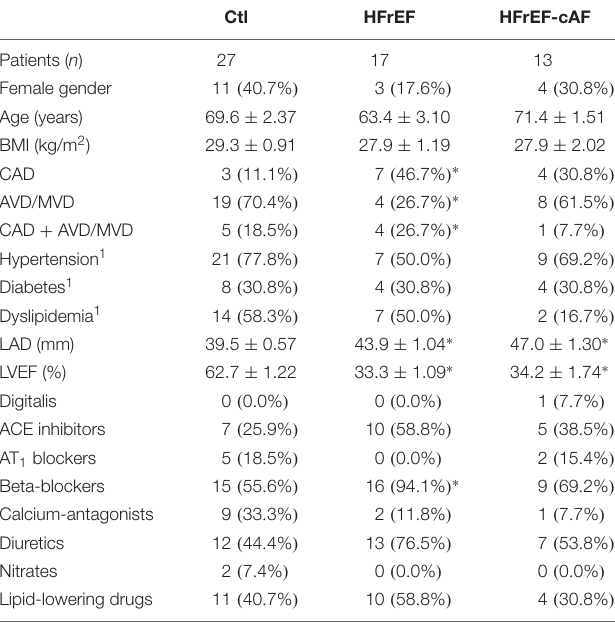
TABLE 3 | Clinical characteristics of patient samples employed for biochemical